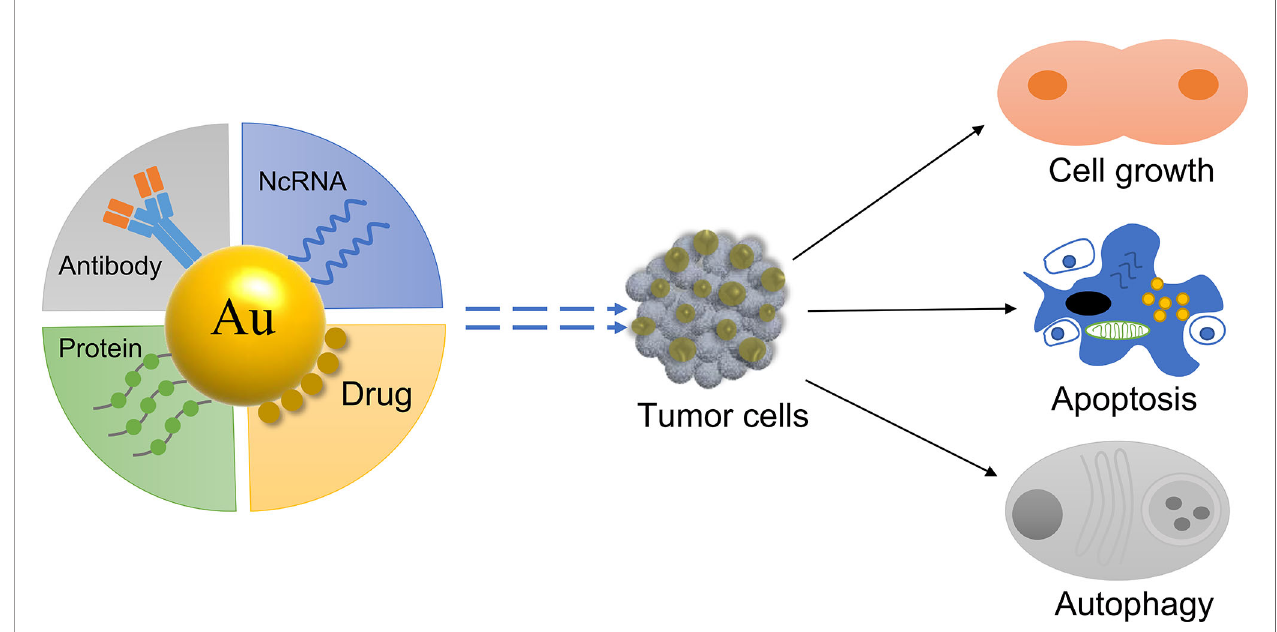
FIGURE 2 | Delivery using GNPs to regulate tumor cell